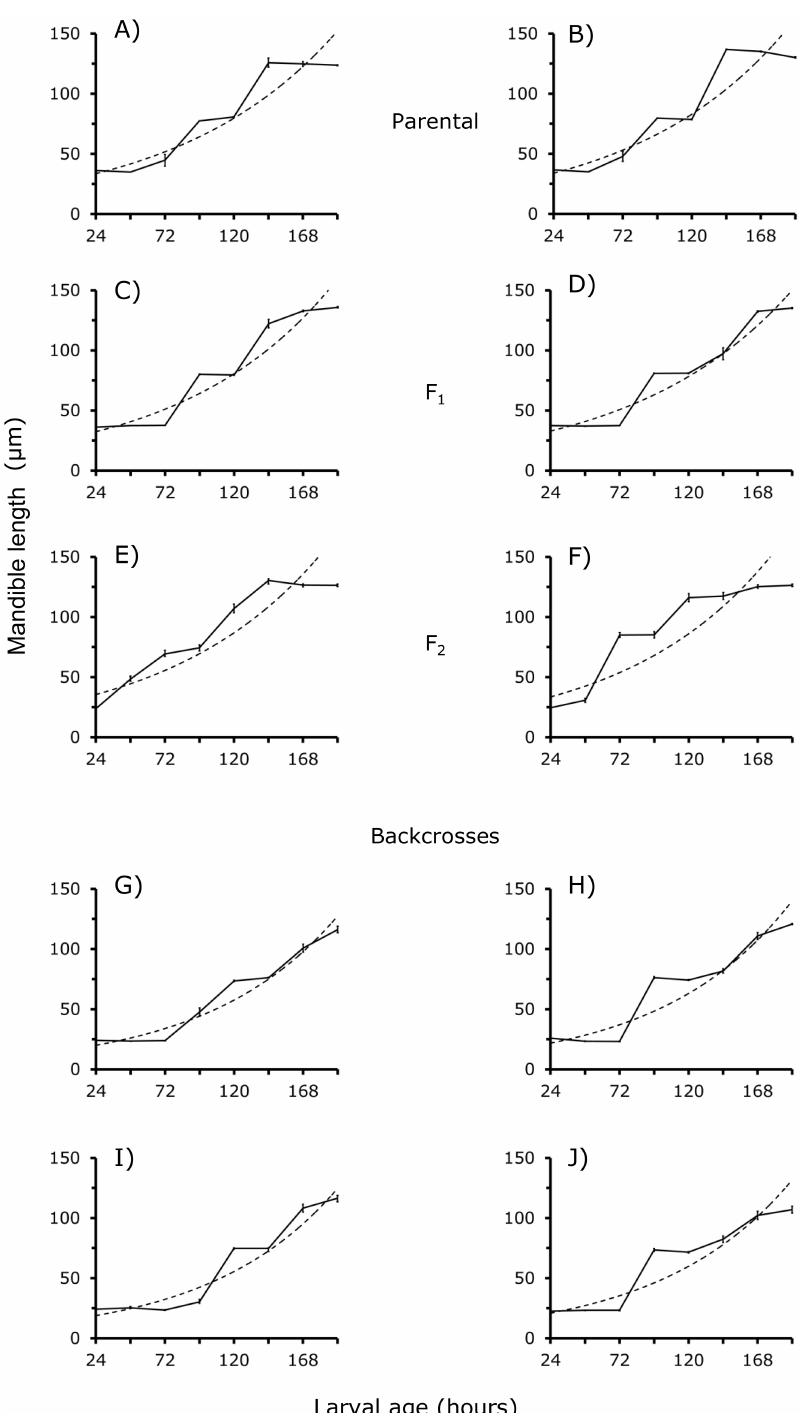
Fig 1. A—J. Growth in length ( μ m) of mandibles M in D . gaucha larvae (solid line). The exponentialfunction describing the growth of this body part is shown by the broken line. BA parentalstrain, A. CJ parental strain, B. ReciprocalF 1, C and D. Reciprocal F 2 , E and F. Reciprocal backcrosses, G—J. For further detailssee Materials and methods and Tables 2 and 3. When standard errors are not shown is becausethey are too